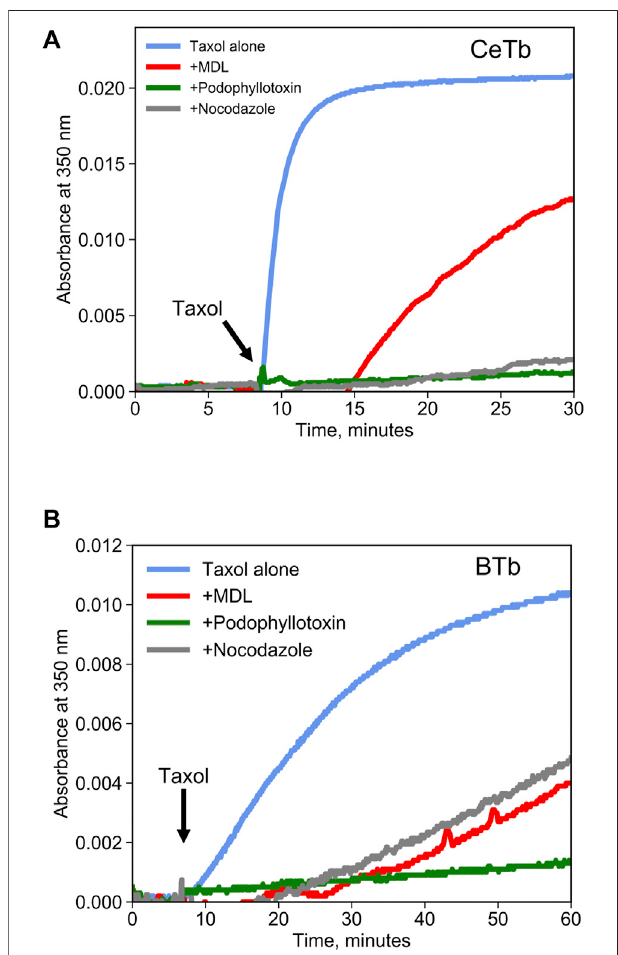
FIGURE 2 | Inhibition of tubulin polymerization by colchicine-site drugs. Tubulin from brain (A) or from erythrocytes (B) was incubated at 2 µM in polymerization buffer at 37 ° C, and the absorbance at 350 nm was registered for 10 min prior to starting the polymerization by the addition of taxol 2 µM (arrow). Drugs were included in polymerization buffer and used at a concentration of 20 µM.